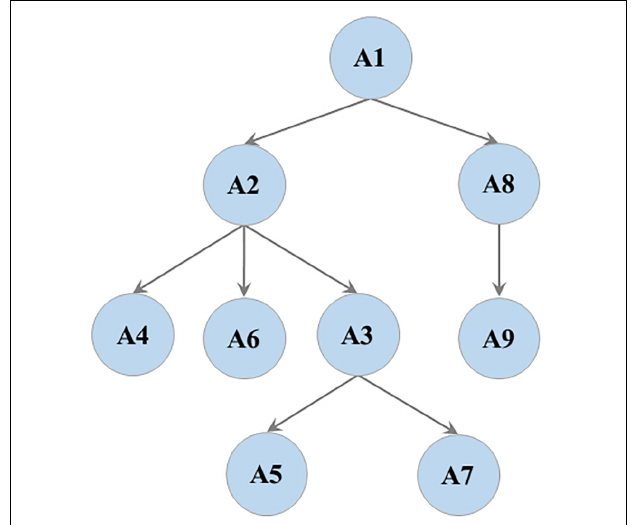
FIGURE 1 | The attribute